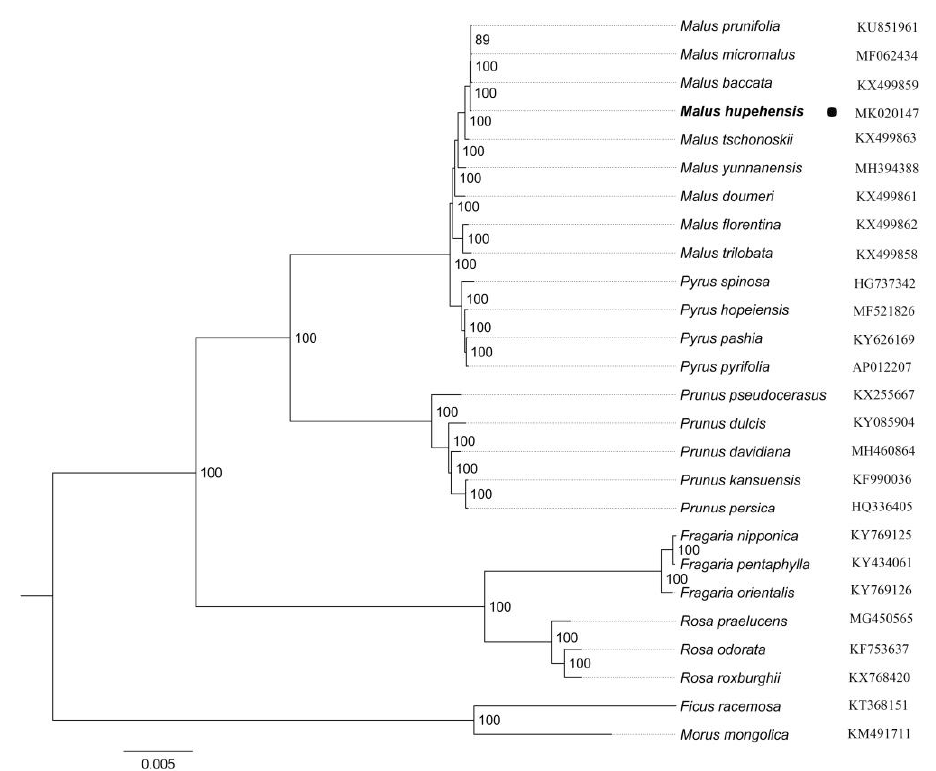
Figure 6. A maximum likelihood (ML) phylogenetic tree based on 26 species chloroplast genomes was constructed. Ficus racemosa and Morus mongolica (Moraceae) were used as the outgroup.